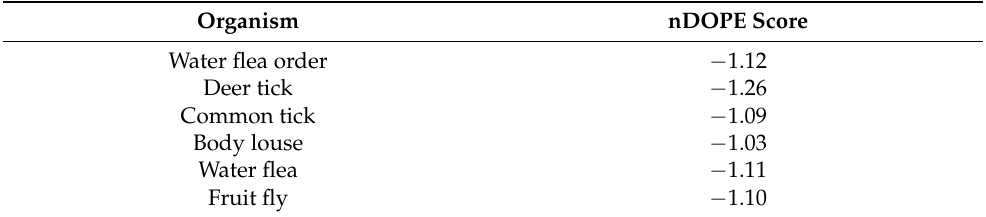
Table 3. Normalised DOPE scores of SARS-CoV-2 Wuhan-Hu-1 S-protein: ectoparasite ACE complexes.